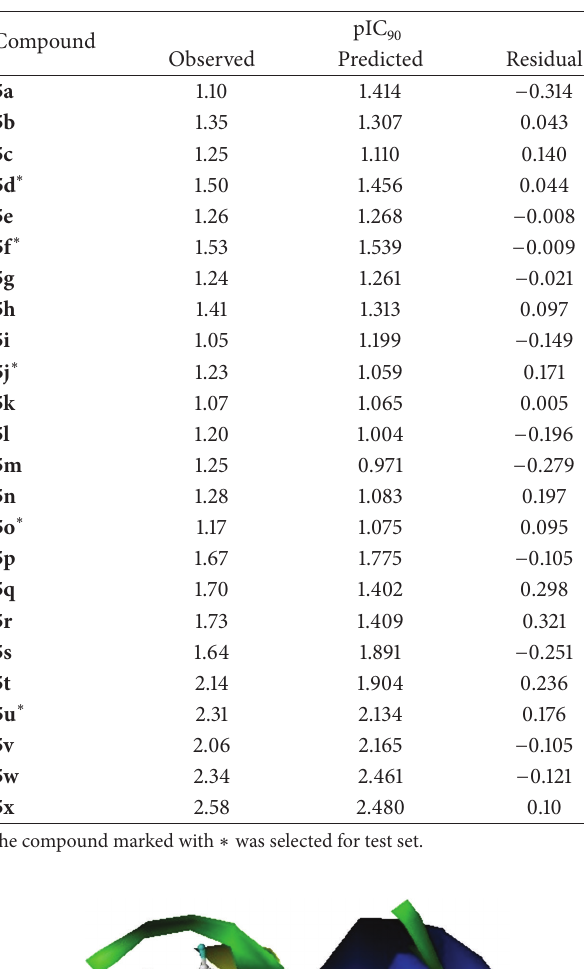
Table 5: Observed and predicted activities for training and test set of Amaranthus mangostanus L. CoMFA model.